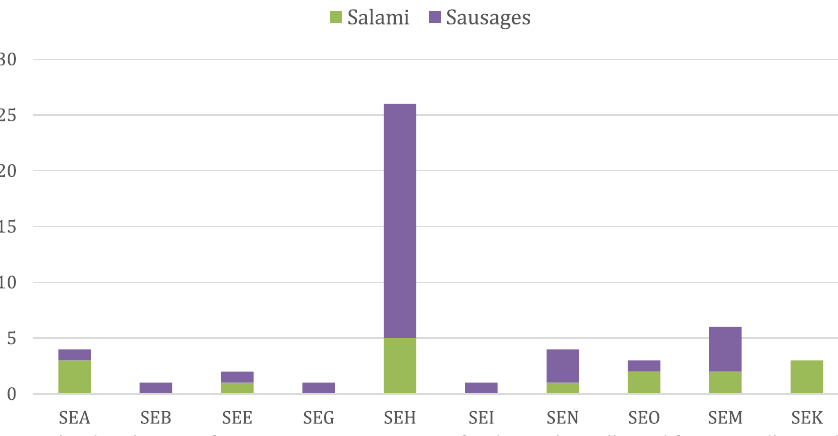
Fig. 2. The distribution of enterotoxin genes among food samples collected from Riyadh, Saudi Table 3. The discovery of mecA gene (147bp), SCCmec types II, III, IVa,IVb, IVd, and V among food smples in Riyadh, Saudi Arabia Samples